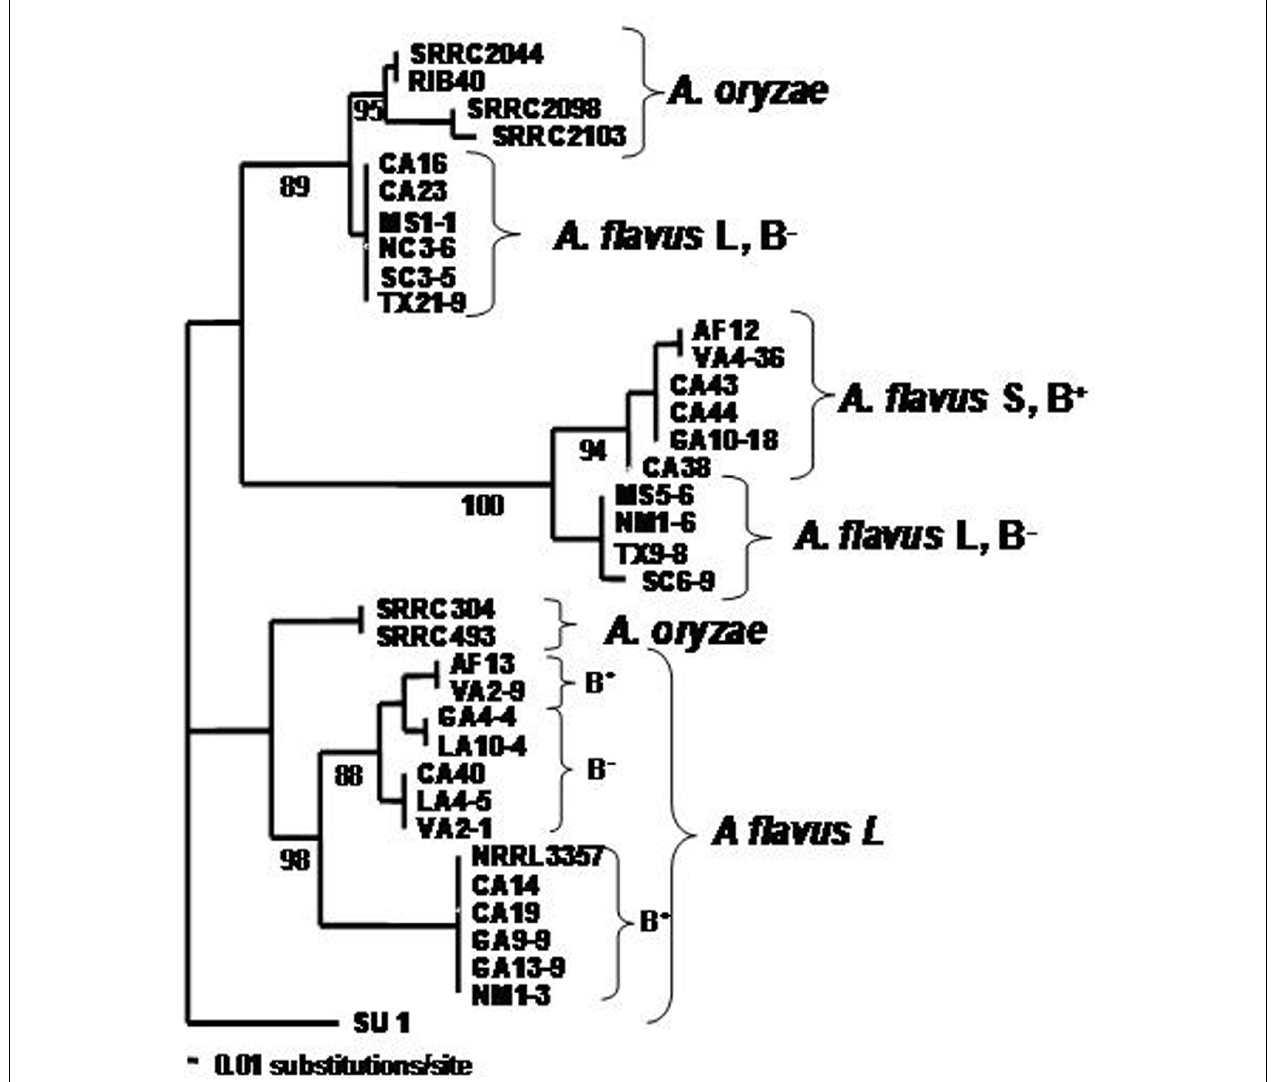
FIGURE 1 | Cladogram illustrating the diversity of A. flavus isolates selected from several different cotton and maize-growing areas in the United States. RIB40 is the Japanese A. oryzae strain used for soy and rice